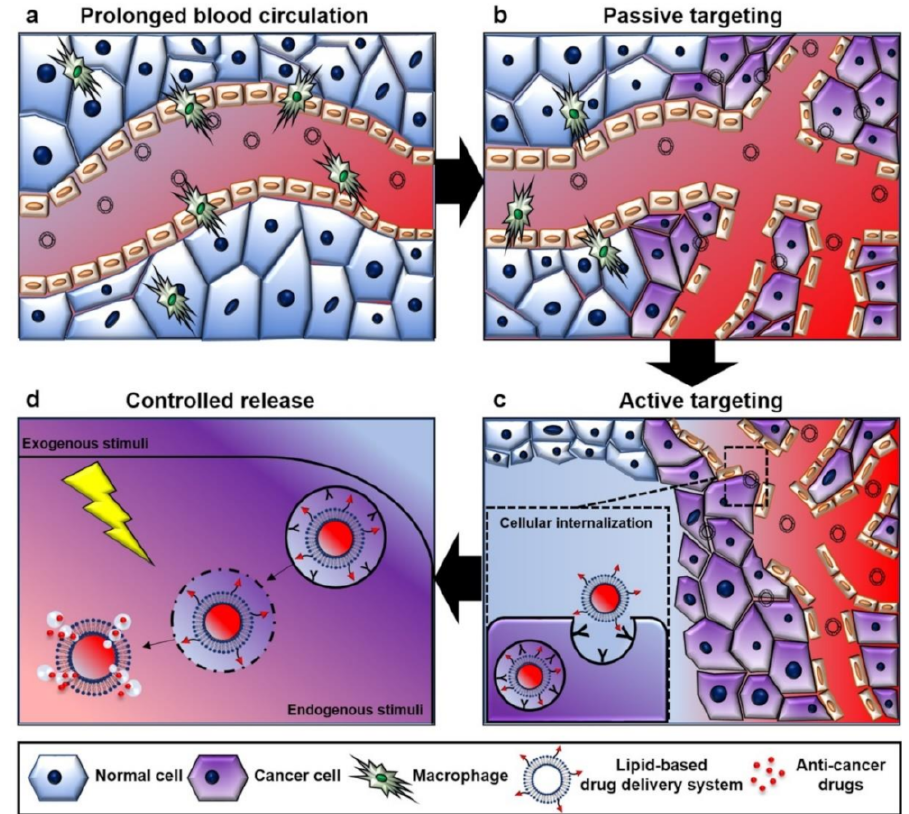
Figure 1. Association of lipid-based drug delivery systems (LBDDSs) with biological systems. Several factors have been considered to increase the delivery efficiency of lipid-based drug delivery systems, including ( a ) prolonged blood circulation, ( b ) passive targeting through the leaky tumor vessels, ( c ) active targeting to penetrate within the tumor, and ( d ) controlled release profile of